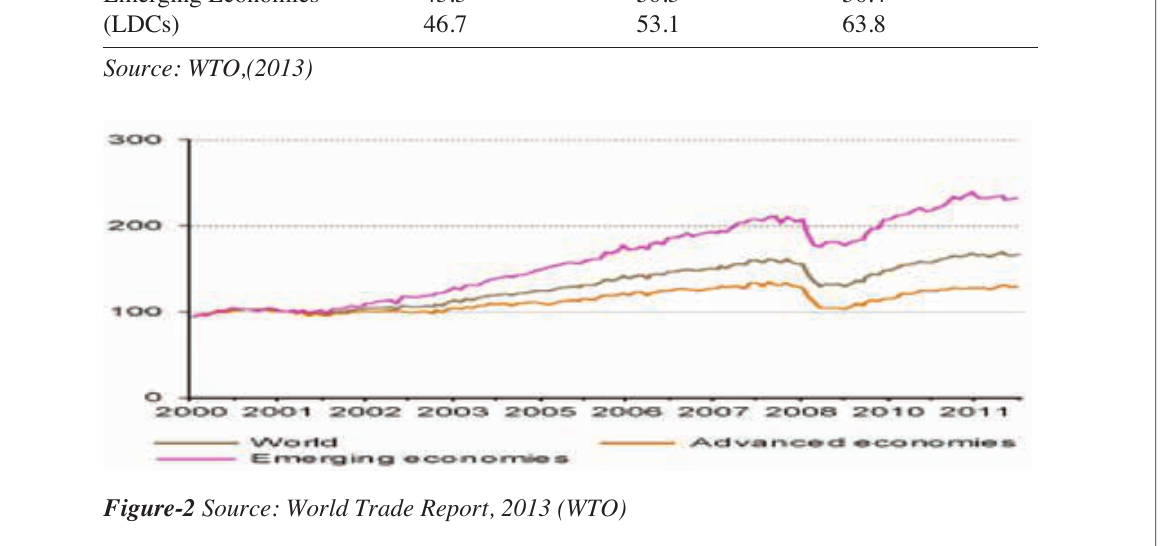
Figure-2 Source: World Trade Report, 2013